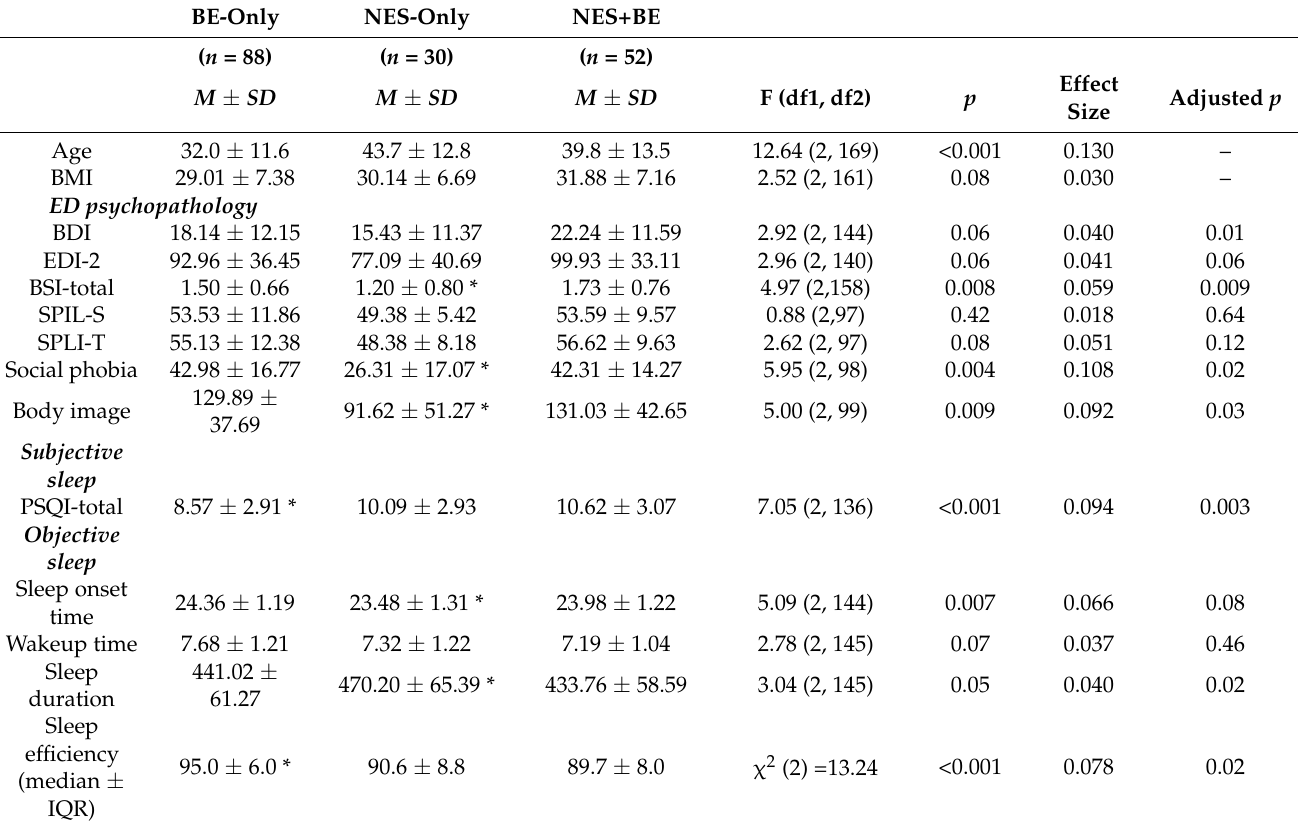
Table 2. Comparison of ED subgroups in ED-related psychopathology and objective and subjective sleep